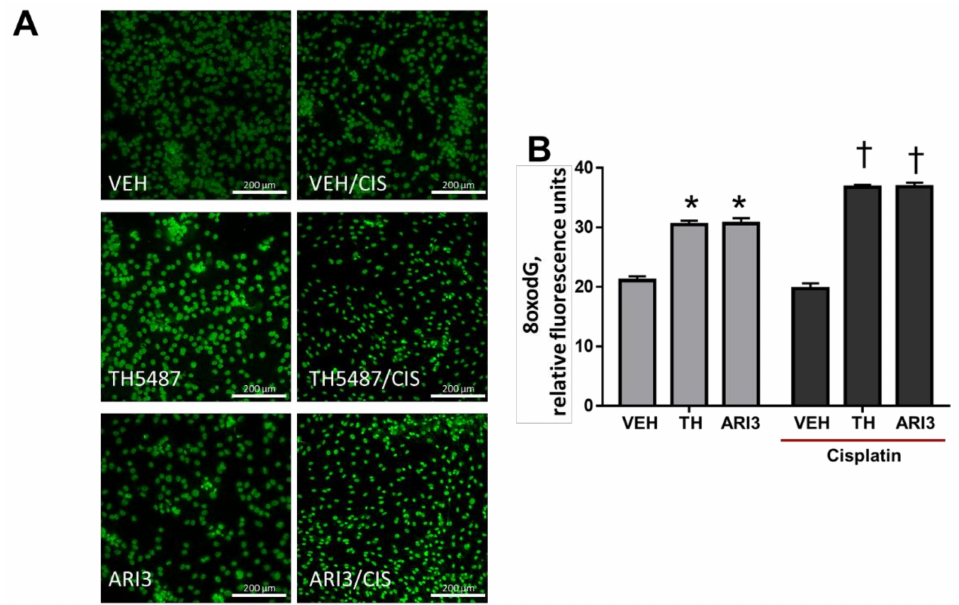
Figure 3. Effects of cisplatin and base excision repair inhibitors on 8-oxodG levels in cells adjacent to sensory neurons. ( A ), Representative immunostaining for 8-oxodG (green) in sensory neuron cultures. The original magnification was × 20. Scale bar represents 200 µ m. ( B ), Quantitative analysis of the integrated density of 8-oxodG staining within PGP9.5+ regions of the image field, acquired as relative fluorescence units using Cytation5 software. * p < 0.0001 comparing TH and ARI3 to VEH; † p < 0.0001 comparing TH/CIS and ARI3/CIS to inhibitors alone, two-way ANOVA with Tukey’s